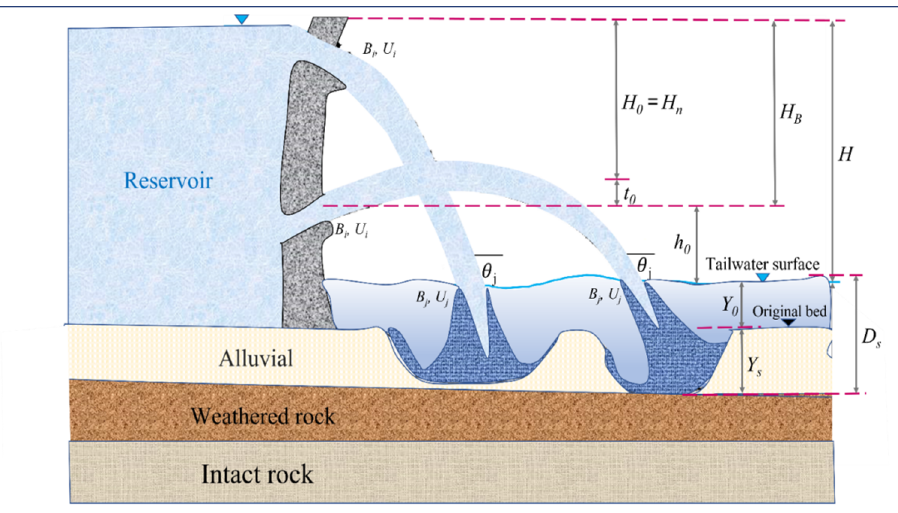
Figure 6. Scheme of scour in semi-theoretical methods [50].